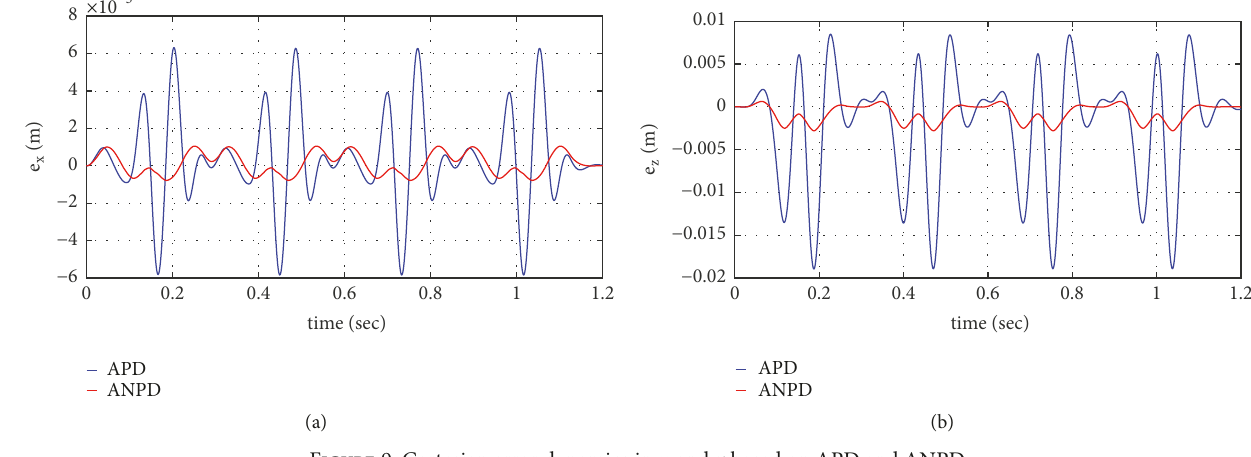
Figure 9: Cartesian error dynamics in 𝑥 and 𝑧 based on APD and ANPD.